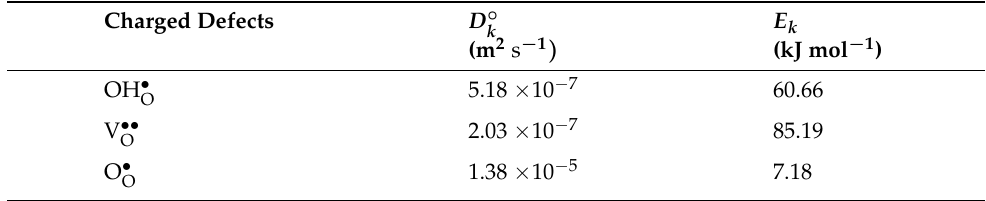
Table 2. Pre-exponential factors and activation energies for diffusivities of mobile charged defects in BZY20. Reproduced with permission from Zhu et al. [4]. Copyright The Electrochemical Society,